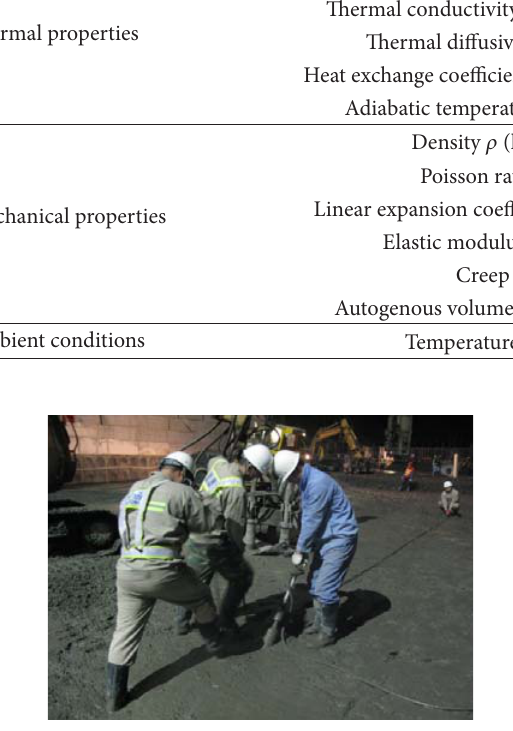
Figure 6: The burying process of